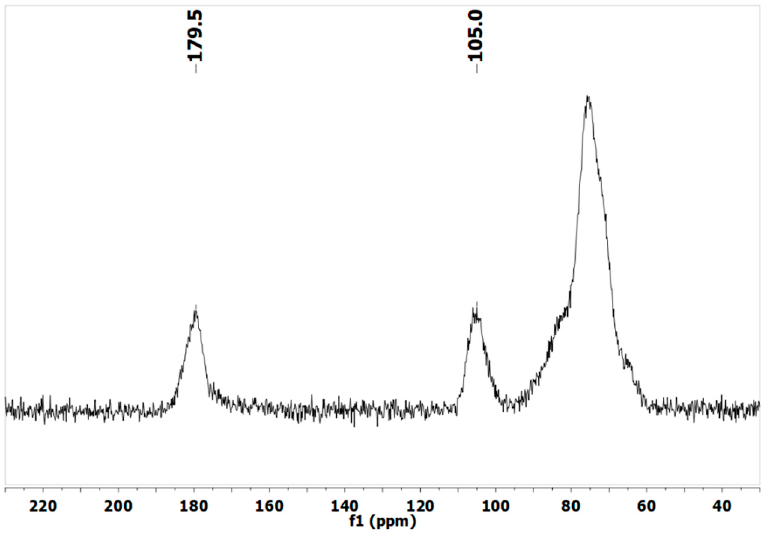
Figure 3. Solid-state 13 C NMR spectrum of carboxymethylated botryosphaeran (CM-BOT).